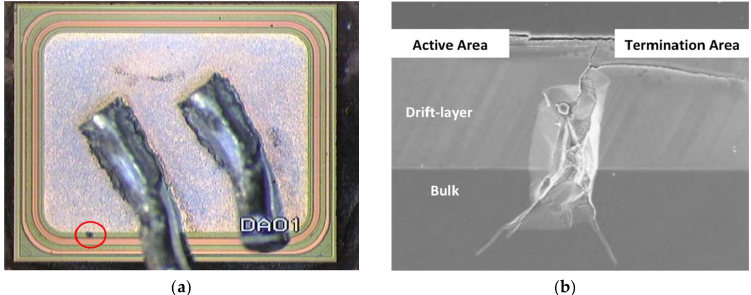
Figure 1. ( a ) An optical microscope picture of a typical failure location (highlighted by the red circle) on the anode side of the device after the electrostatic discharge (ESD) test for the 600 V rated fast recovery epitaxial diode (FRED) diode. The two black wires connect by wire bonding to the anode and the failure occurs in the area between the active area and the termination area; and ( b ) a scanning electron microscopy (SEM) section of the failure